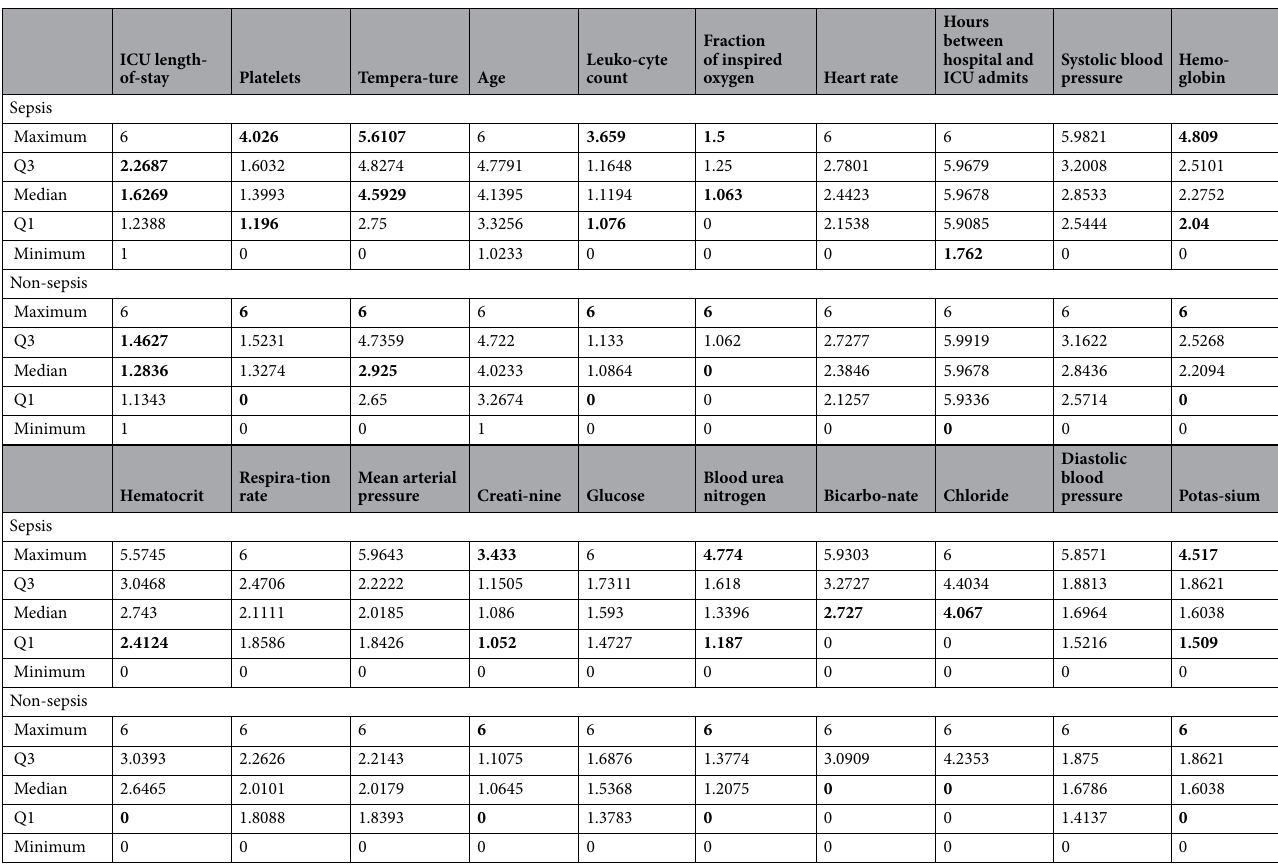
Table 4. Statistical description for the top 20 features from RF (zero-shift) model. Q1 and Q3 stands for the first and third quartiles. The minimum, first quartile, median, third quartile and the maximum of a variable are often used as an empirical distribution approximation. Note that a minimum of 0 refers to missing values. Significant values are in